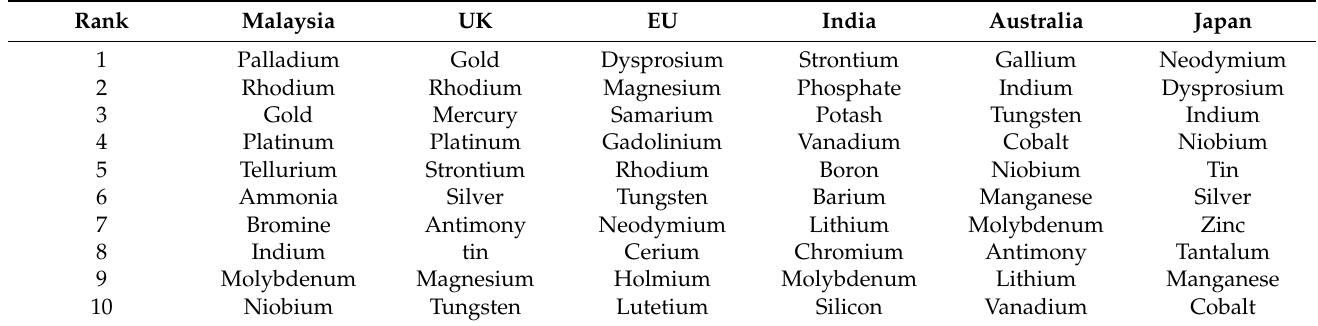
Table 8. International comparisons with Malaysia on top ten critical